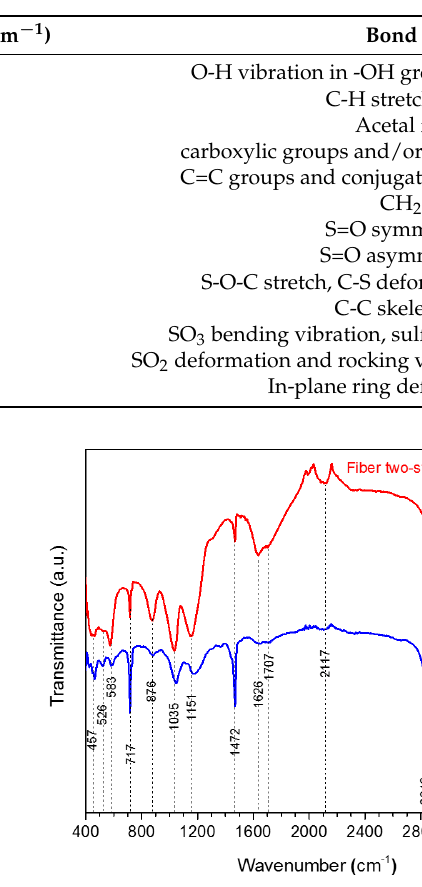
Table 2. Identified ATR-FTIR peaks introduced by crosslinking due to the sulfonation reaction.